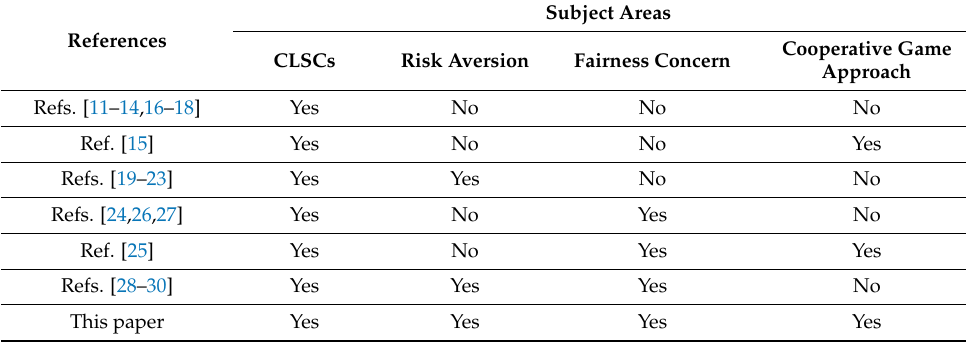
Table 1. An overview of characteristics of the literature and this